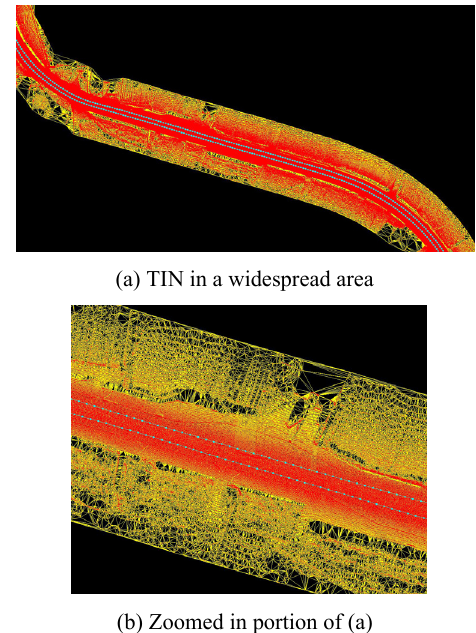
Figure 7. Example of TIN generation result for MMS data